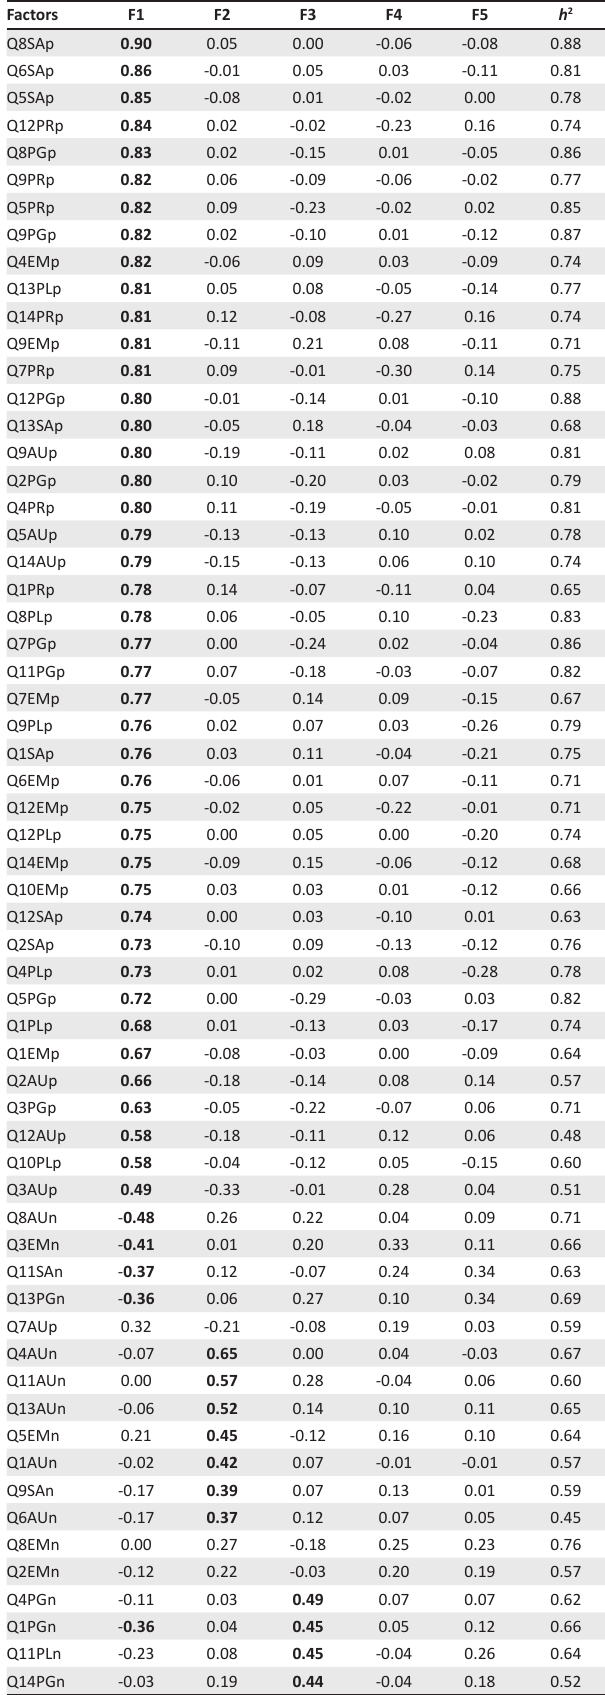
TABLE 2: Maximum likelihood analysis with direct oblimin rotation pattern matrix for the Ryff Scales of Psychological